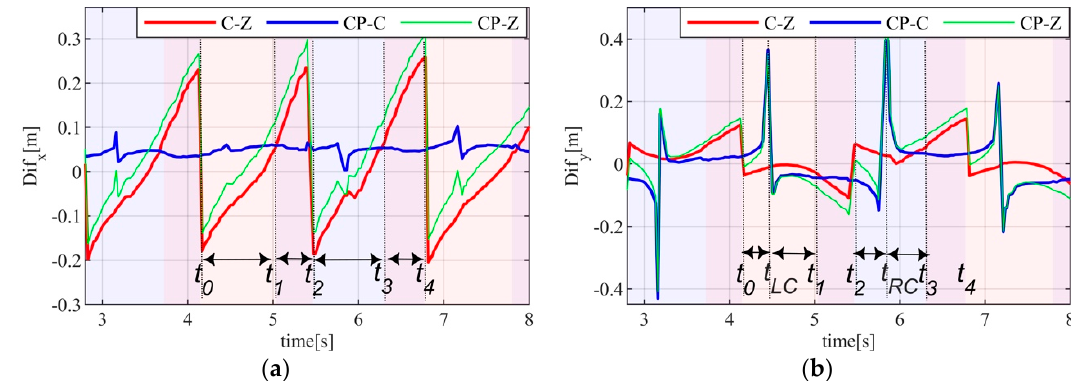
Figure 8. Di ff erence values in stability indices and the CP to examine the relation between indices: ( a ) Di ff erence values in x-time table (C-Z: value of x COG — x ZMP , CP-C: value of x CP — x COG , and CP-Z: value of x CP — x ZMP ); ( b ) Di ff erence values in y-time table (C-Z: value of y COG — y ZMP , CP-C: value of y CP — y COG , and CP-Z: value of y CP — x ZMP ).